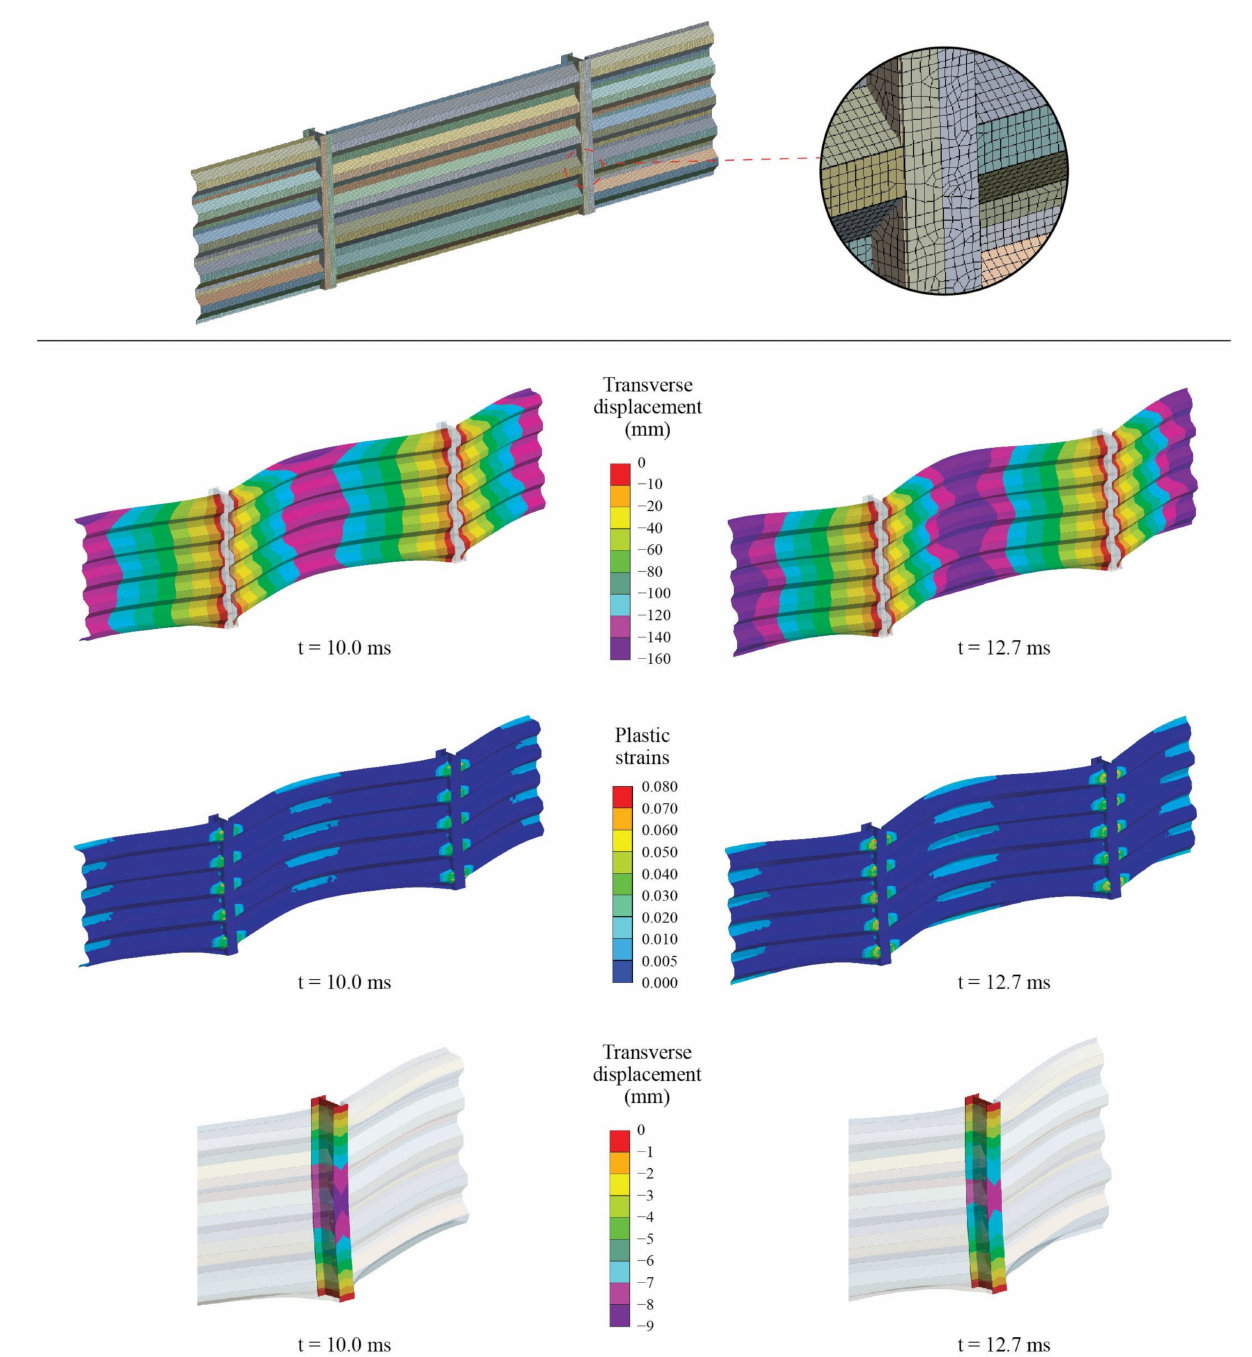
Figure 12. Meshing and results of the case study numerical model when cladding is subjected to 200 kPa maximum blast pressure and 1500 kPa ms impulse (15 ms positive phase